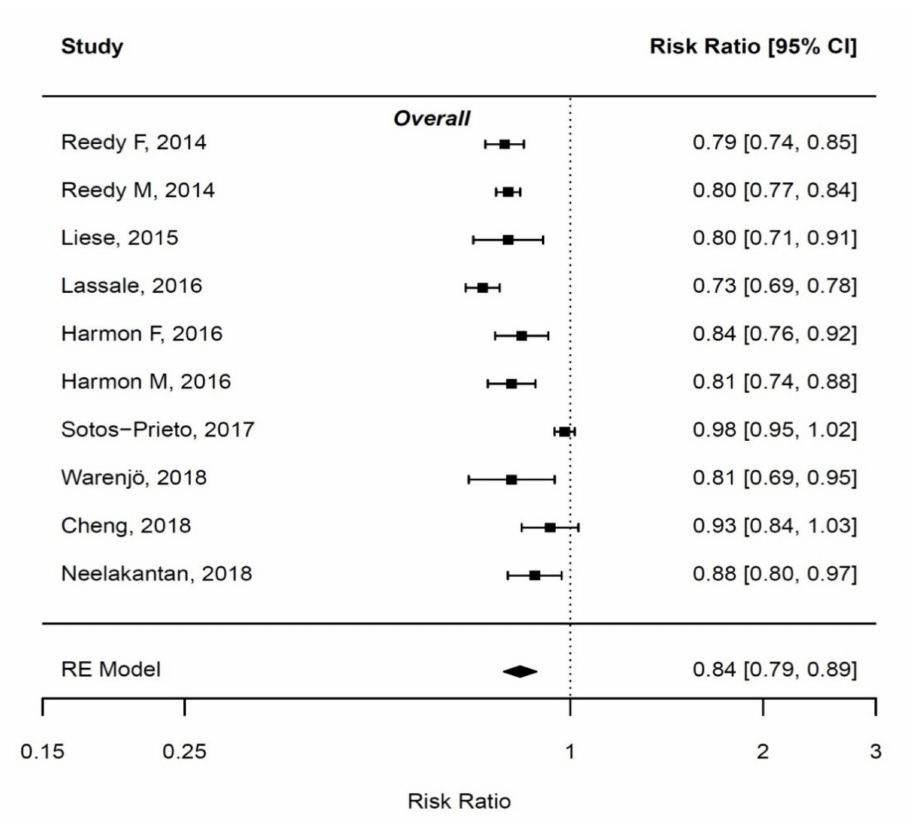
Figure 2. Meta-analysis under random-e ff ects model (REM) with regard to adherers to the Mediterranean diet (MD) (high vs. low) and overall cancer mortality. F = females, M =